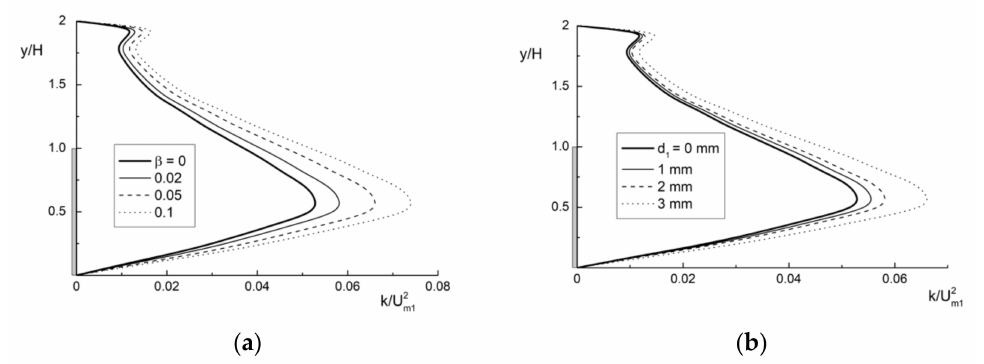
Figure 13. The effect of the gas volumetric flow rate ratios ( a ) and gas bubbles diameter at the inlet ( b ) on the carrier fluid phase